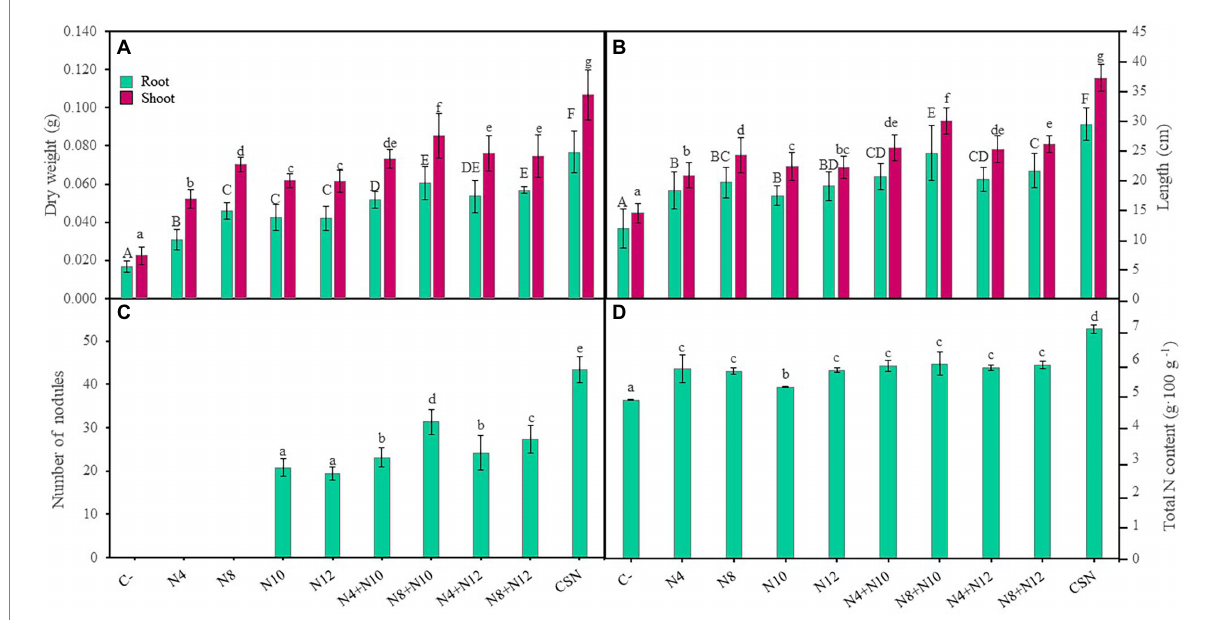
FIGURE 3 Effects of the inoculation of M. sativa plants with PGPNE. (A) Dry weight of shoot and roots, (B) length of shoot and roots, (C) number of nodules, and (D) nitrogen content after 60 days in pots containing soil from the high marshes of the Odiel River. Values are means ± S.D. ( n = 16). Different letters indicate statistical differences between means. Lowercase and uppercase letters are used to qualify different variables and are not comparable among them (One-way ANOVA, LSD test, p < 0.001). C-: non inoculation; N4: inoculation with Pseudomonas sp. N4; N8: inoculation with Pseudomonas sp. N8; N10: inoculation with Ensifer sp. N10; N12: inoculation with Ensifer sp. N12; N4 + N10: co-inoculation with Pseudomonas sp. N4 and Ensifer sp. N10; N8 + N10: co-inoculation with Pseudomonas sp. N8 and Ensifer sp. N10; N4 + N12: co-inoculation